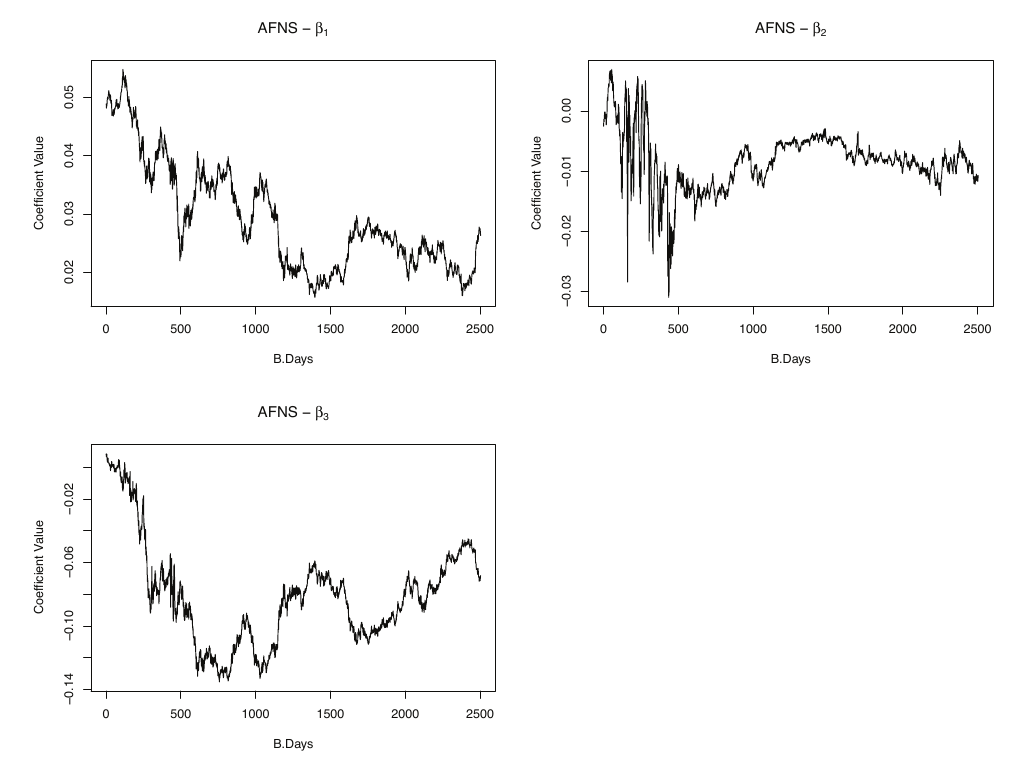
Figure 2. AFNS coefficient series.